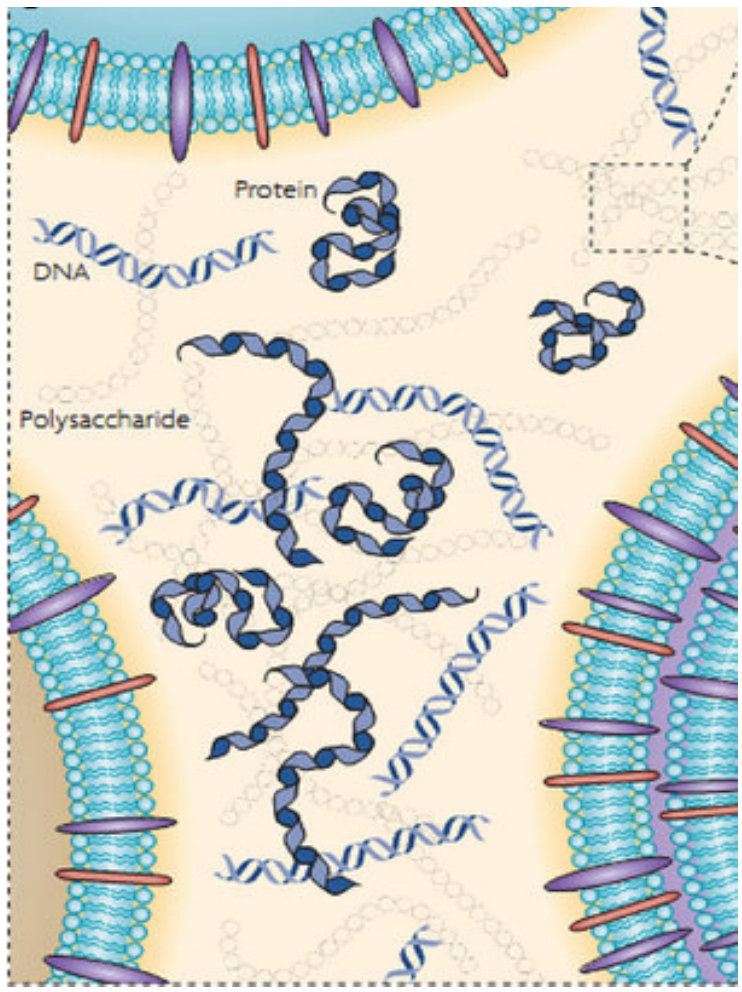
Figure 5. The main constituents that form EPS are molecules of polysaccharides, proteins, nucleic acids, and lipids. Abbreviation: EPS, extracellular polymeric substances.